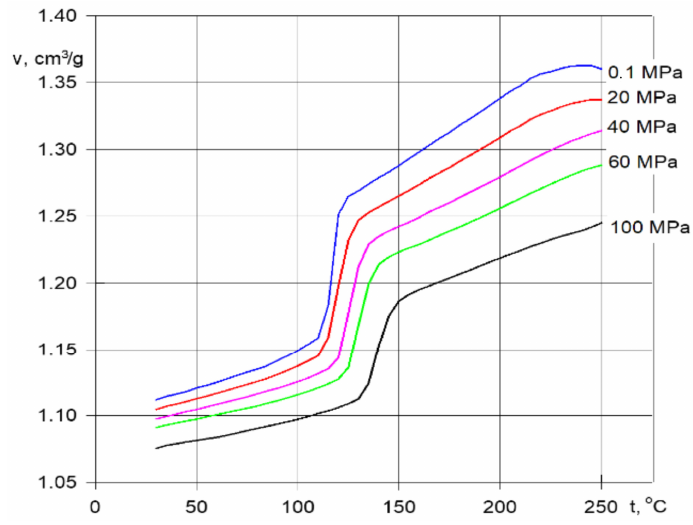
Figure 5. p-v-T plot of